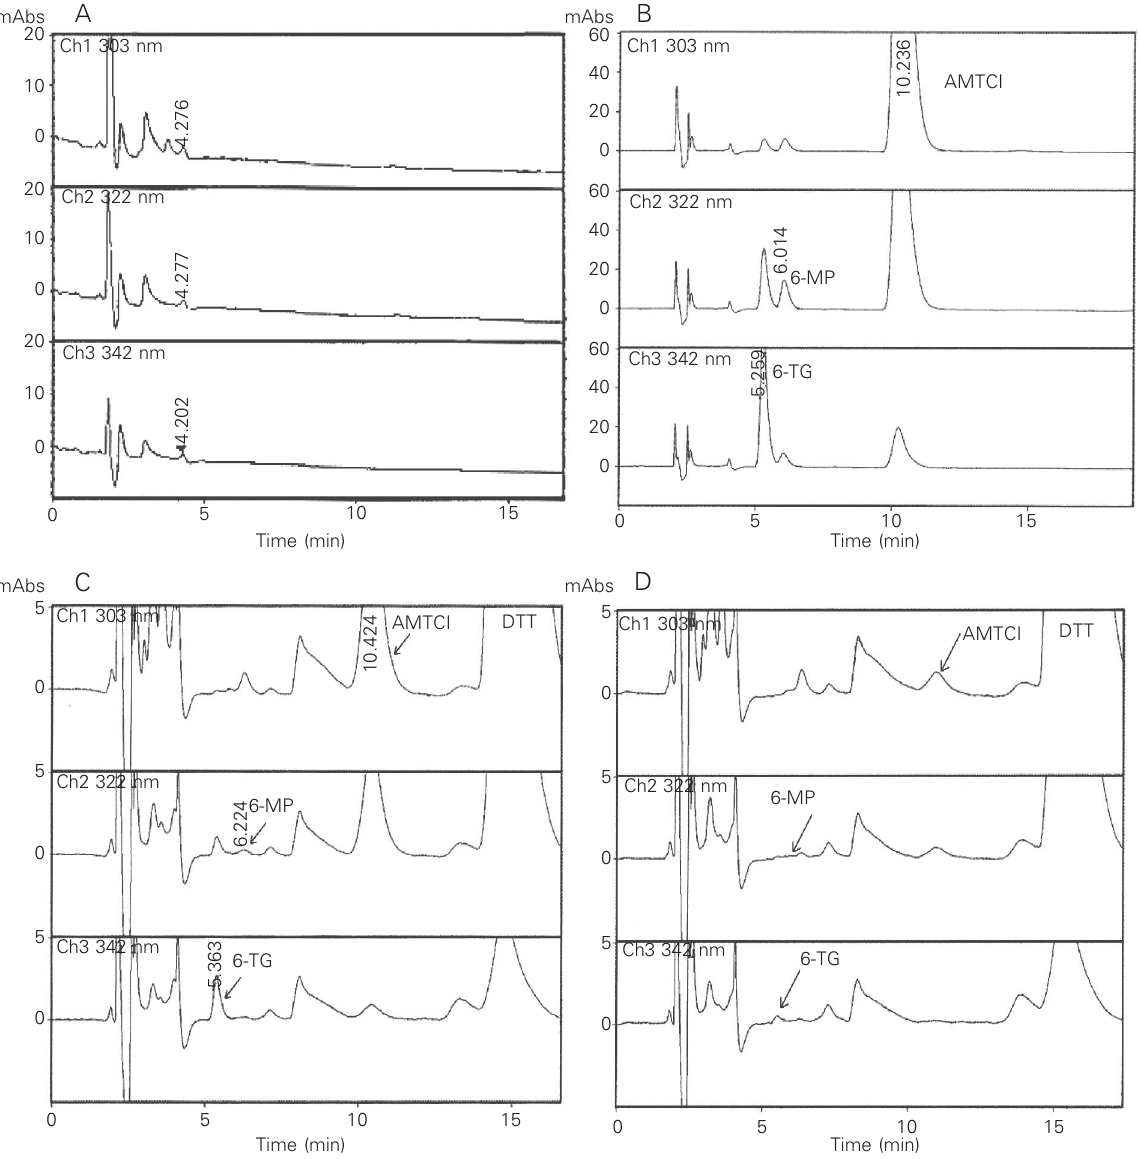
Figure 2. A , HPLC elution diagrams of a blood sample obtained from a healthy volunteer which was processed and then analyzed by HPLC using a Radial-Pak Resolve C18 column (100 x 8 mm; 5 µm particle size, eluted with methanol-water (7.5:92.5, v/v) containing 100 mM triethylamine adjusted to pH 3.2 with phosphoric acid; the flow rate was 1.4 ml/min; detection was by a photodiode array with channel 1 at 303 nm, channel 2 at 322 nm, and channel 3 at 342 nm. B , HPLC chromatogram of standard mixture 2 (see Table 1). Sample processing and HPLC analysis were as described in A . C , HPLC chromatogram of a blood sample collected from a patient using 6-MP at a dose rate of 47.8 mg m -2 day -1 . Sample processing and HPLC analysis were as described in A . D , HPLC chromatogram of a blood sample from the same patient as in C who had missed taking 6-MP at a dose rate of 58.1 mg m -2 day -1 , showing low levels of the metabolites 6-TG and MMP (AMTCI). Sample processing and HPLC analysis were as described in A . AMTCI = 4-amino-5-(methylthio)carbonyl imidazole; DTT = dithiothreitol. For other abbreviations, see Figure